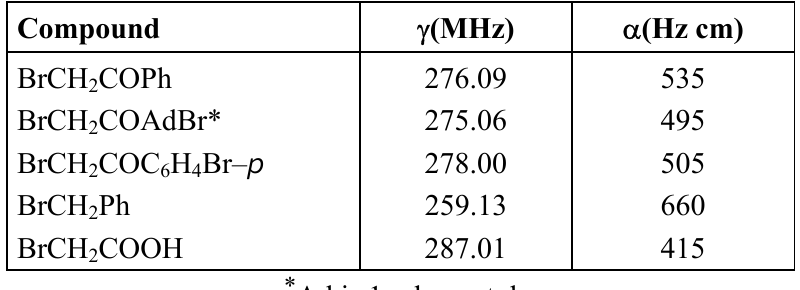
Table 4. 79 Br-NQR Spectra of BrCH